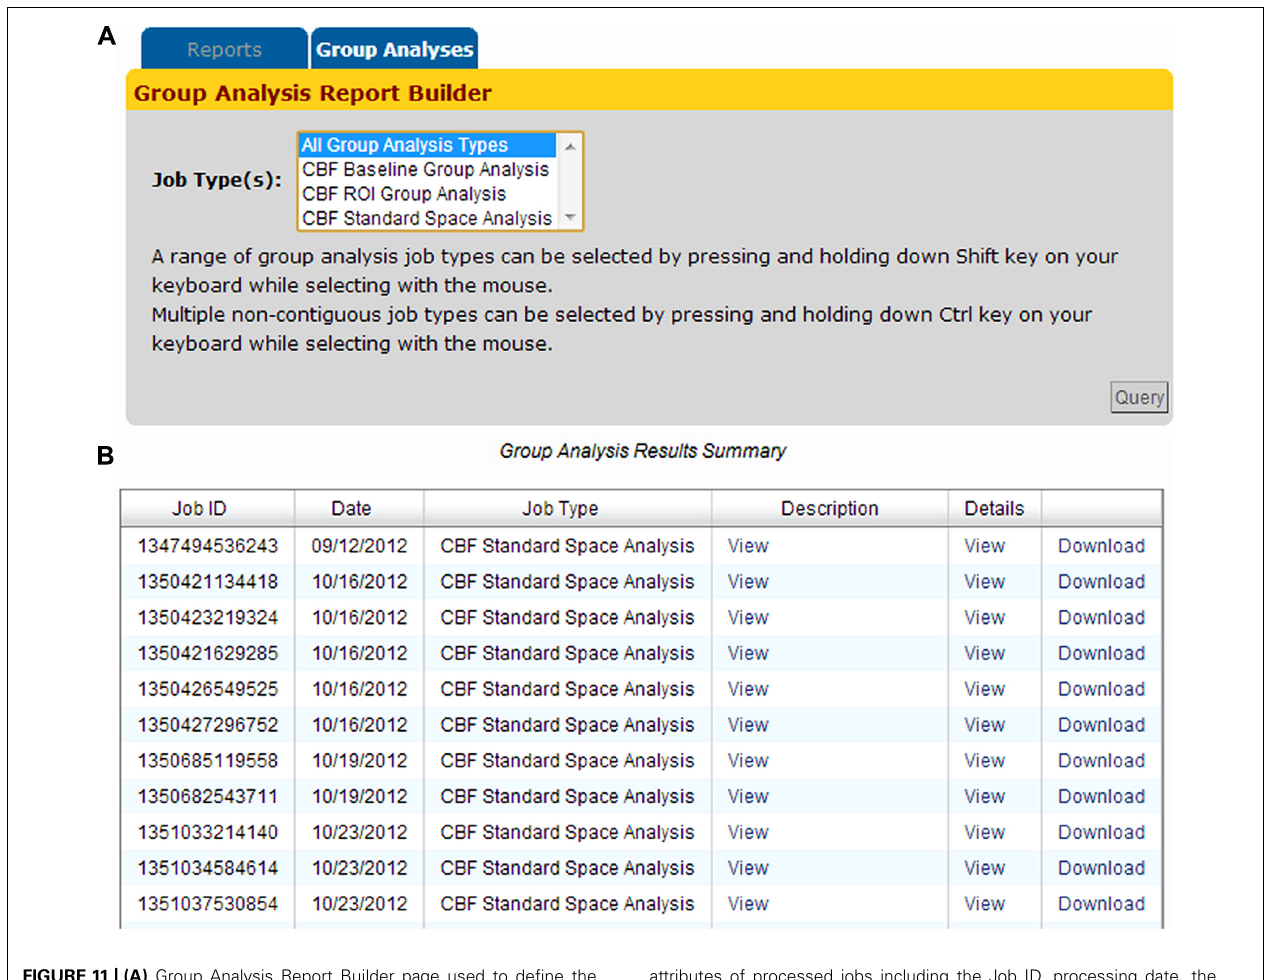
attributes of processed jobs including the Job ID, processing date, the type of group analysis performed, and a pop-up window containing a summary of the statistical analysis tables and